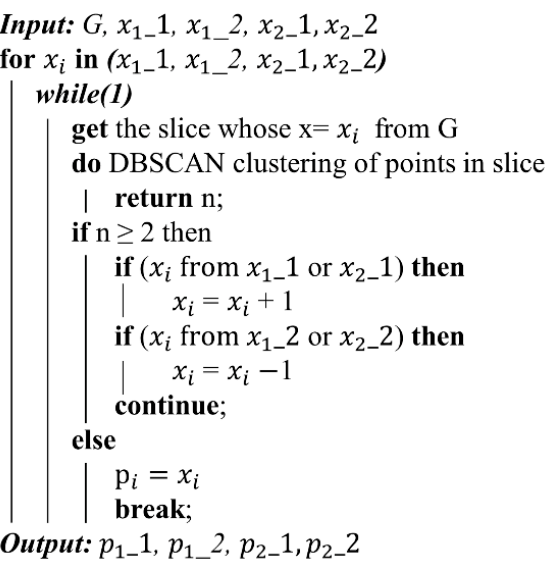
from the DBSCAN clustering algorithm.